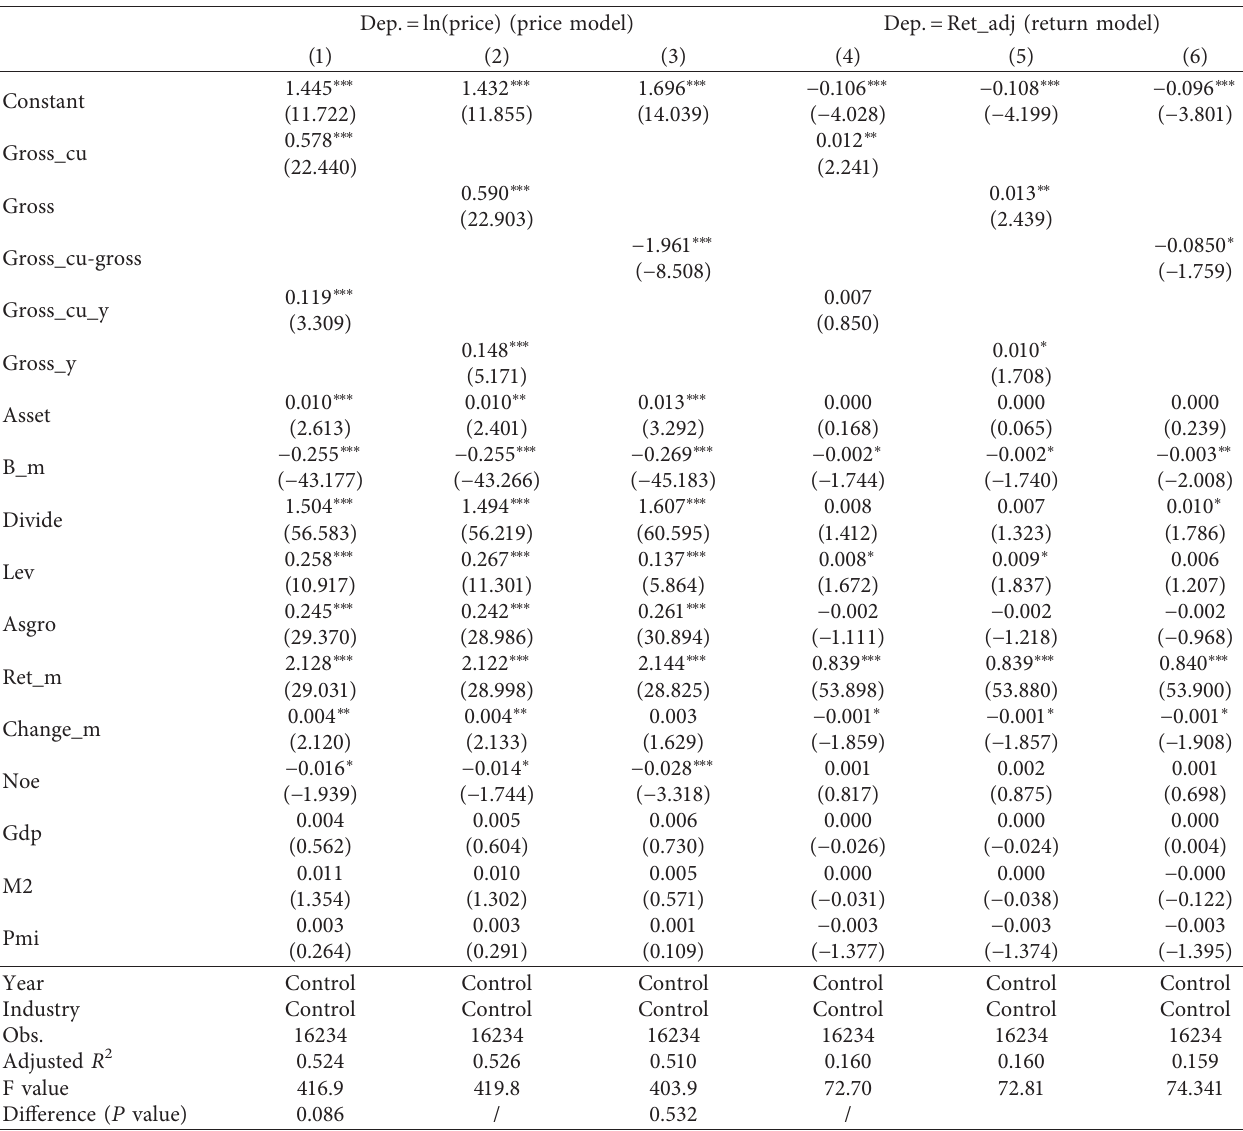
Table 4: Regression